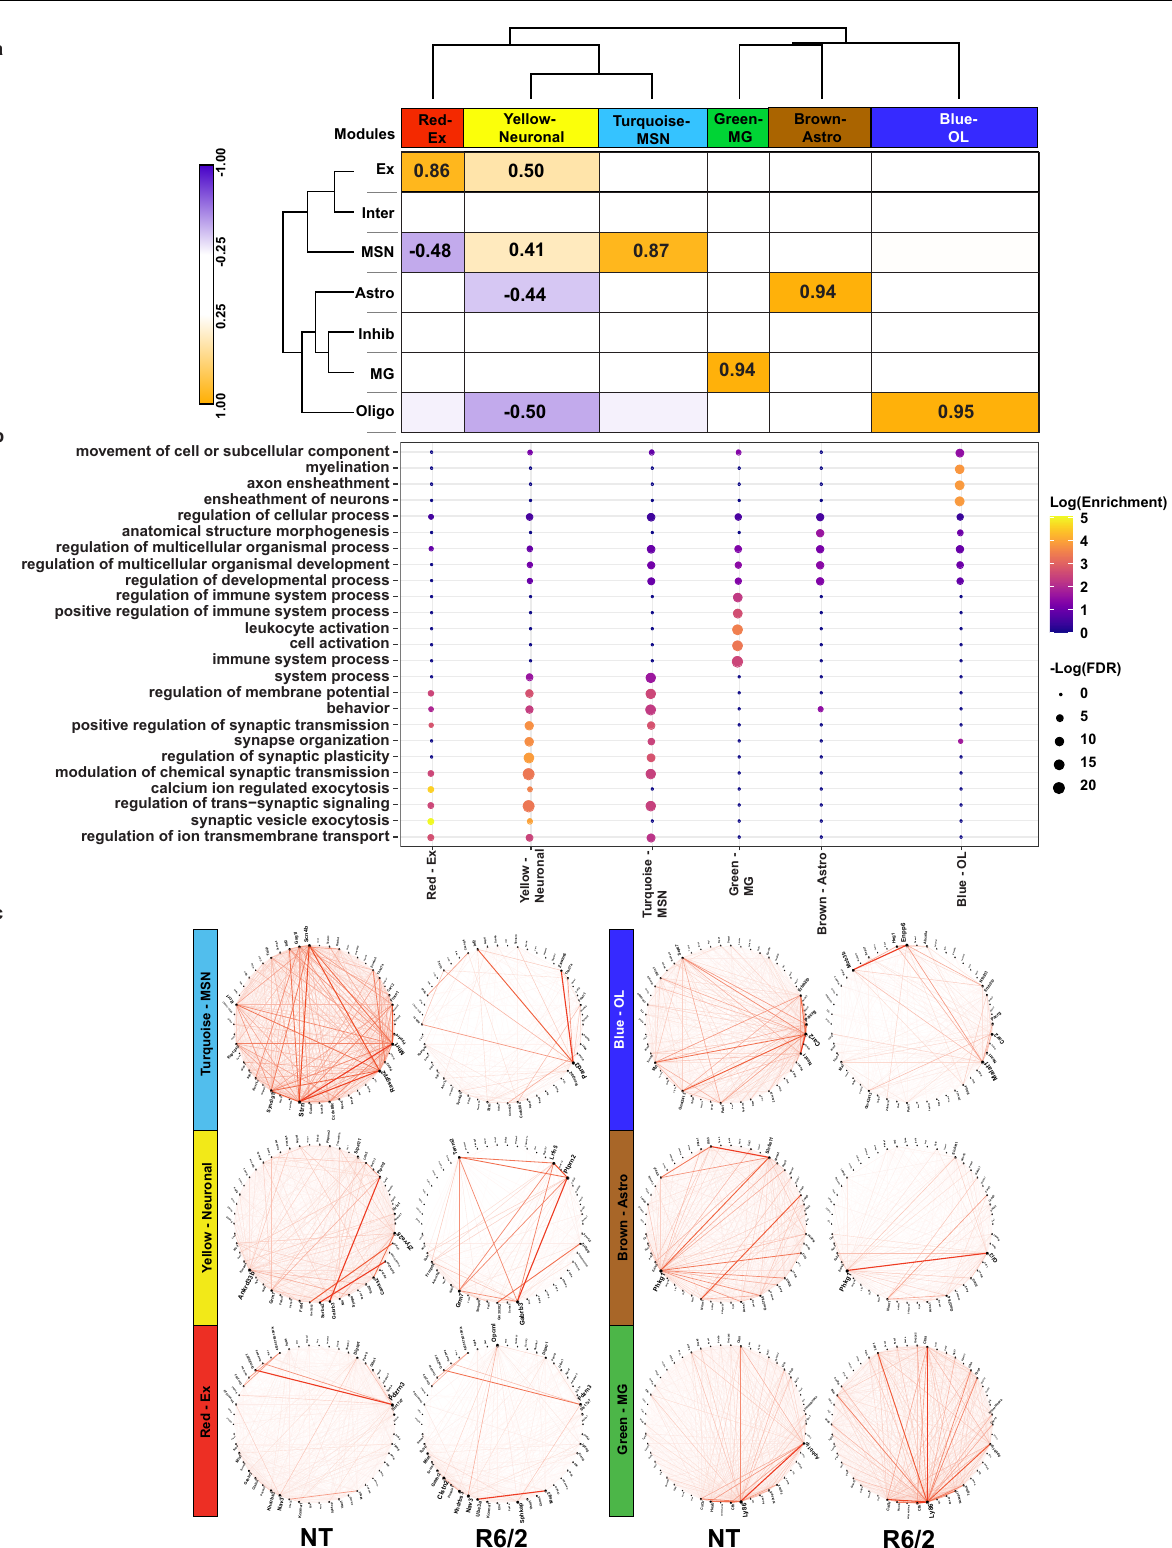
Fig. 3 | WGCNA analysisofR6/2 mousesnRNAseqdatashowscelltype-speci fi c changes in network structure. a Dendrogram and correlation heatmap showing cell type-speci fi c co-expression modules. Heatmap shows modules highly corre- lated with each cell type, dendrogram shows clustering of neuronal module together and glial together. Cell color represents column min (blue) and max (orange). Any statistically signi fi cant trait-module correlations are shown with